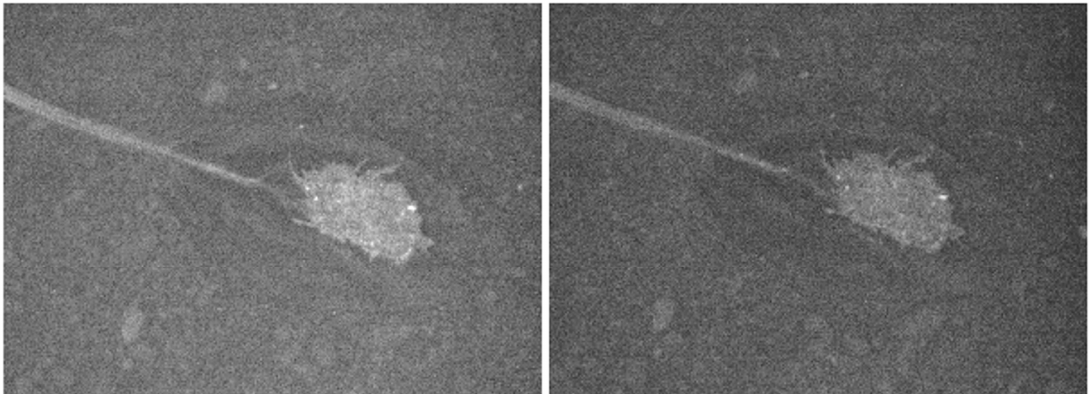
Figure 5. Gain 20 ( left ) and gain 32 ( right ) images at 525 nm of manure on a spinach leaf. Images were acquired at dusk with the drape raised 250 cm.